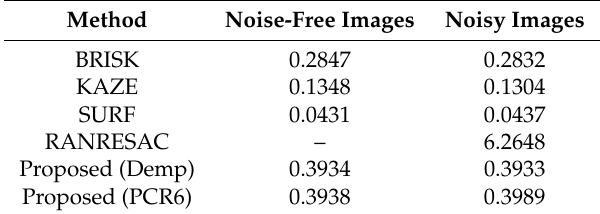
Table 2. Average execution time comparison for sparse algorithms (unit second).